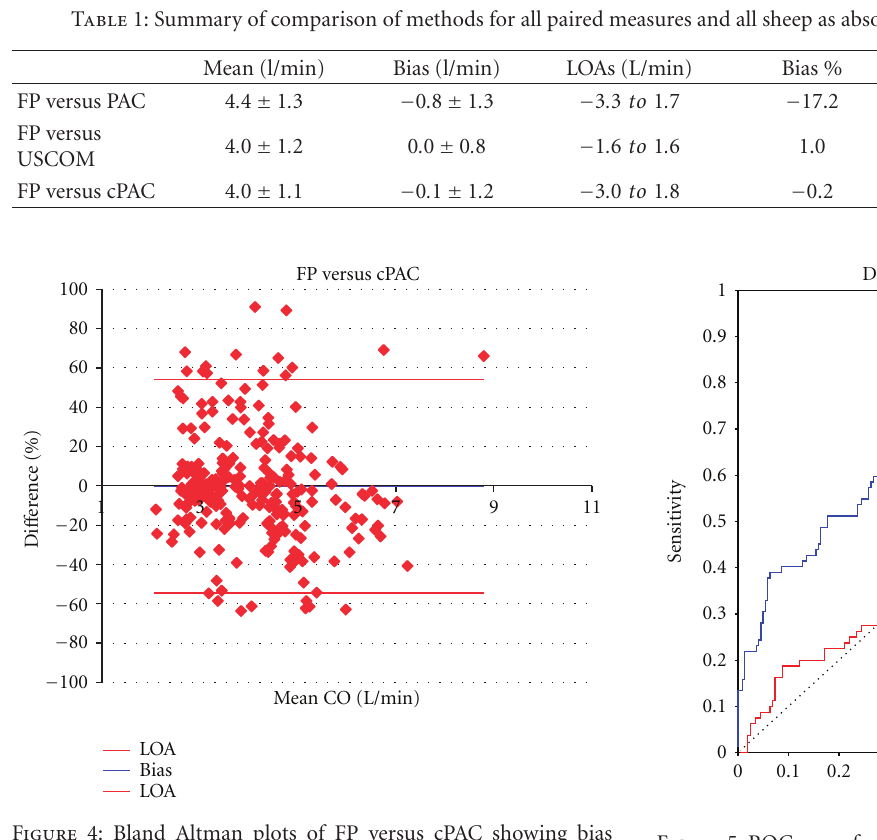
Figure 4: Bland Altman plots of FP versus cPAC showing bias (0.2%) and LOAs ( − 54.7% and 54.2%).